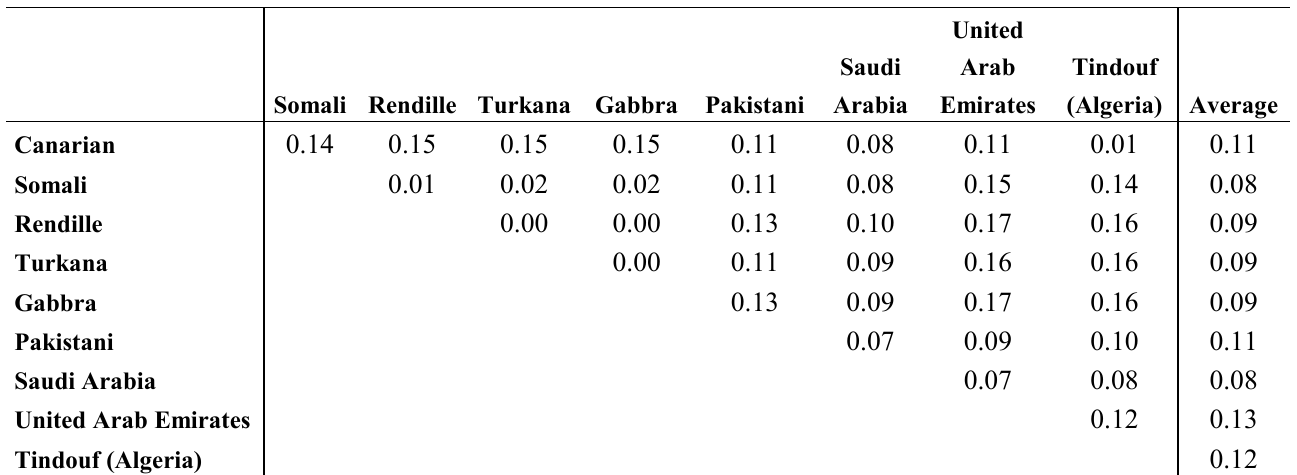
Table 3. Genetic distance, in terms of F differentiation of each population from the